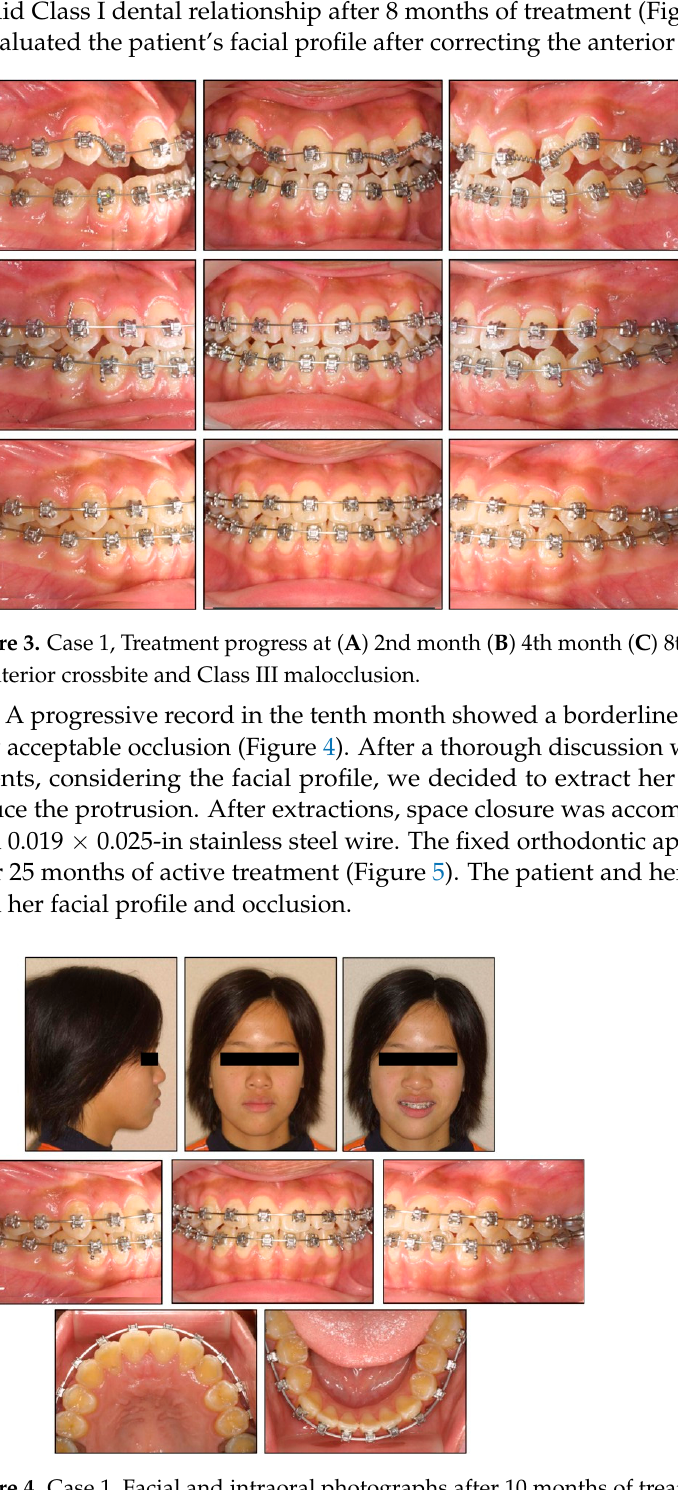
Figure 5. Case 1, Posttreatment facial and intraoral photographs. 2.5. Treatment Results Both arches were well aligned with complete space closure. The occlusion fits well with good interdigitation and super Class I molar relationship. A posttreatment pano- ramic radiograph showed acceptable root parallelism without any apparent root resorp- tion (Figure 6), but more work might be required on the mandibular second premolars to improve root angulation. A posttreatment lateral cephalogram showed a harmonious lip profile. Cephalometric superimpositions revealed only minor retraction of the mandibu- lar incisors. Even with four premolar extractions, the maxillary incisors were moved slightly forward to maintain appropriate overjet with the mandibular incisors accompa- nied by mandibular growth (Figures 6 and 7). Progressive facial profile changes show an improved facial profile with the extraction approach (Figure 8).